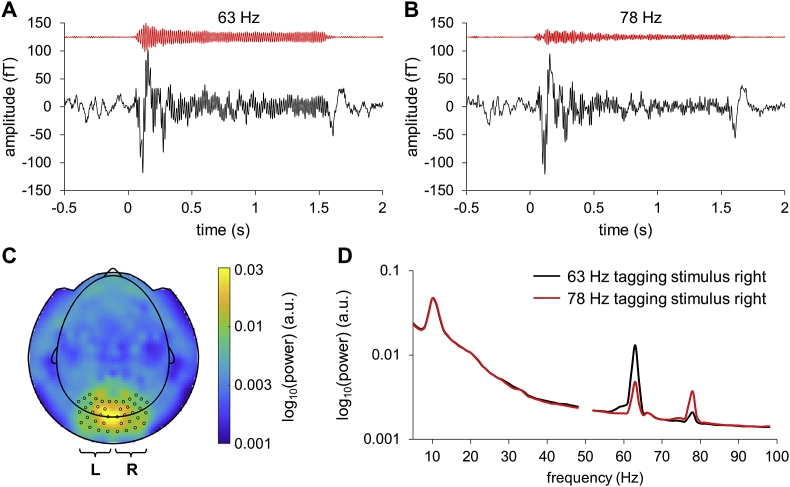
Event-related fields for a representative participant showed clear responses at the tagging frequencies. Note that the frequency tagged signals were presented with the same phase over trials. (A) Broadband (black line) and narrowband (red line) trial-averaged ERFs for 63 Hz stimulus (presented right) for the left occipital sensors (see panel C). (B) Trial-averaged ERFs for 78 Hz stimulus (presented right) for the left occipital sensors. (C) Left and right occipital MEG sensors that covered areas with the stronger power at the tagging frequencies for all the participants were used in the analysis. (D) Normalized group-level power spectra for the left sensors when the tagged image was presented at 63 Hz and 78 Hz in the right hemifield. Prior to computing individual power spectra, the trials were normalized by the standard deviation of time series over sensors. The line noise with peak near 50 Hz was cut out in the plot.